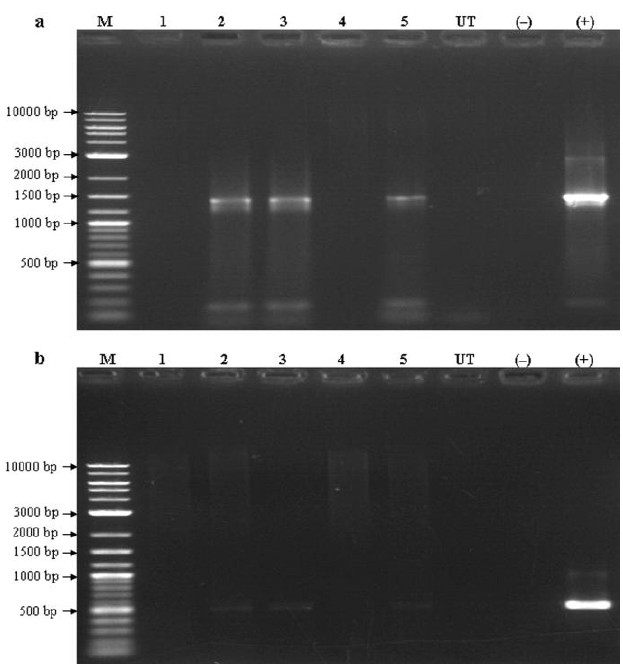
Figure 3. PCR analysis of putative transformed lines. ( a ) and ( b ) The presence of β-glucuronidase ( gusA ) and hygromycin phosphotransferase ( hpt ) genes were detected using gus - and hpt -specific primers, respectively. Three out of five putative lines tested (lines 2, 3 and 5) showed the presence of both gusA and htp genes. Lane M: 2-log DNA marker (New England Biolabs, UK); Lanes 1−5: putative transformed lines; Lane UT: untransformed control; Lane (−): negative control (without DNA template); Lane (+): positive control (pAcRbcS::gusA plasmid